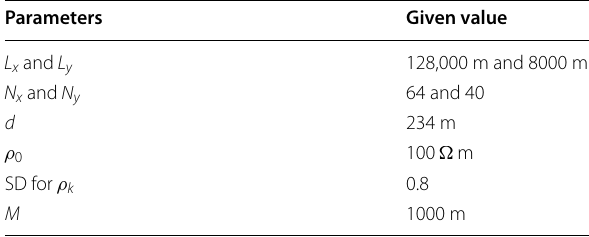
Table 3 Parameters for the oblong distorter model used in this